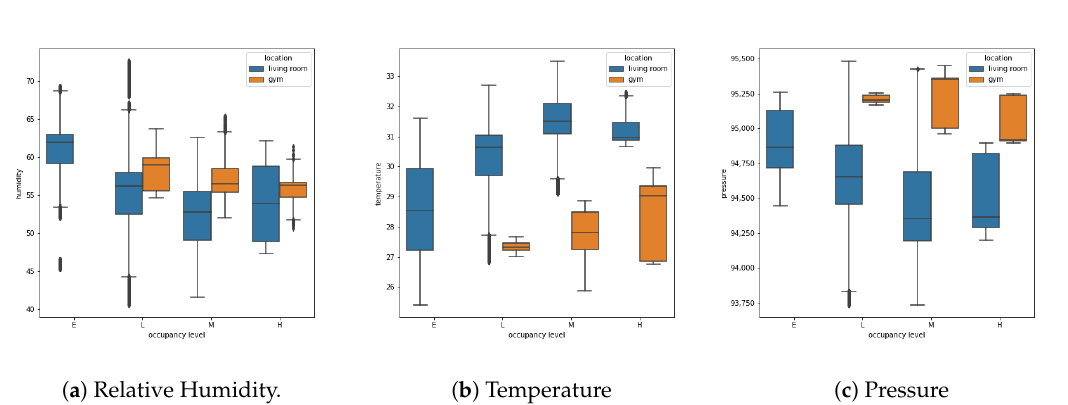
Figure 3. Data distribution for ( a ) relative humidity, ( b ) temperature, and ( c ) pressure grouped by occupancy level and location. Where the occupancy levels are E = Empty, L = Low, M = Medium, and H = High.